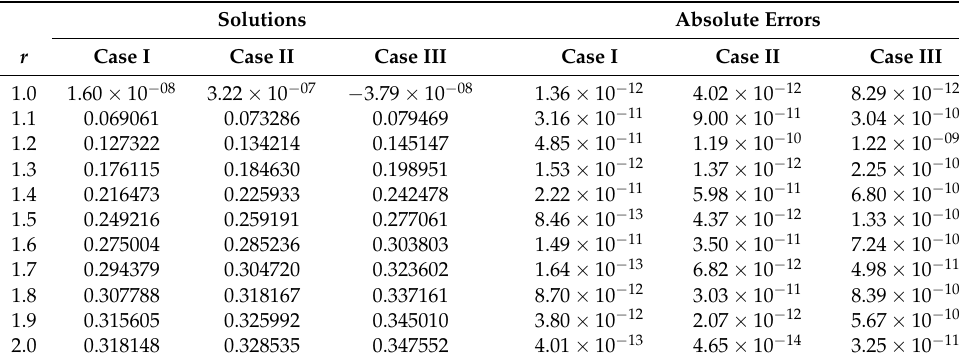
Table 4. Approximate solutions and Absolute errors obtained by the LNN-GNDO-SQP algorithm for SCENARIO II of the drainage